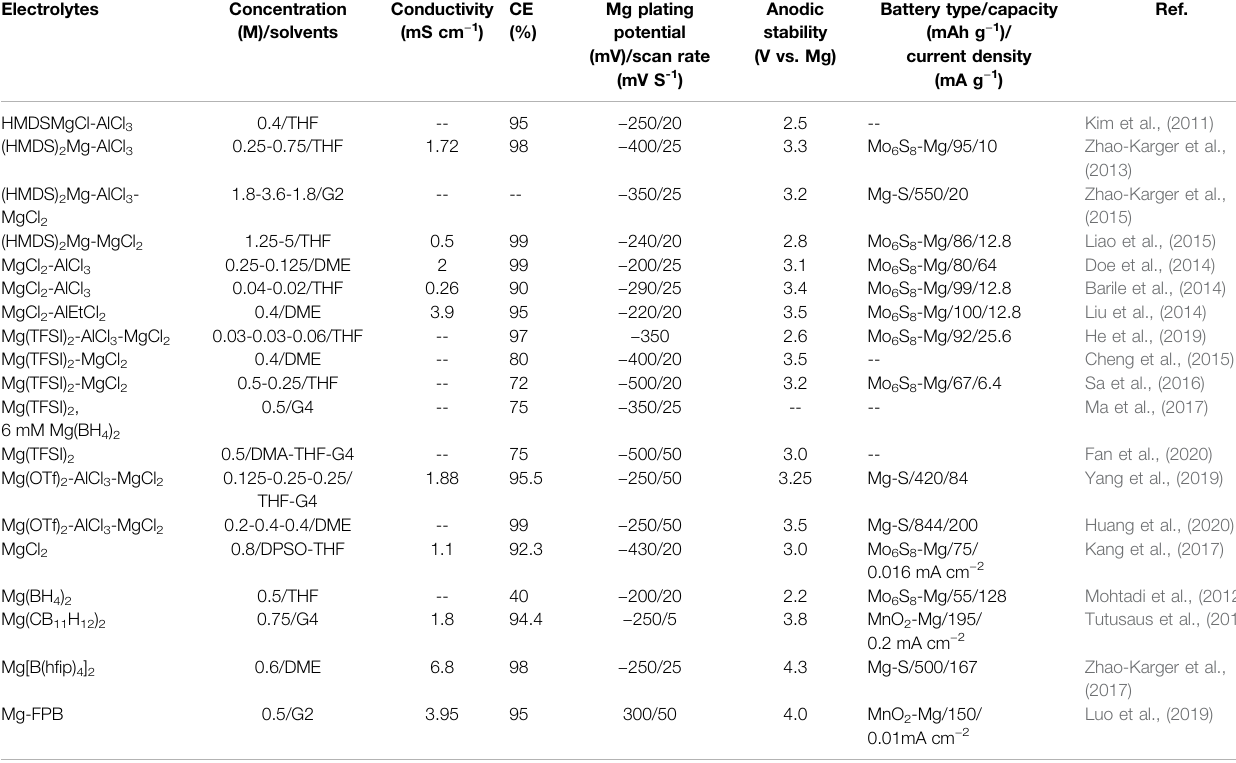
TABLE 1 | Performance of some non-nucleophilic Mg electrolytes.